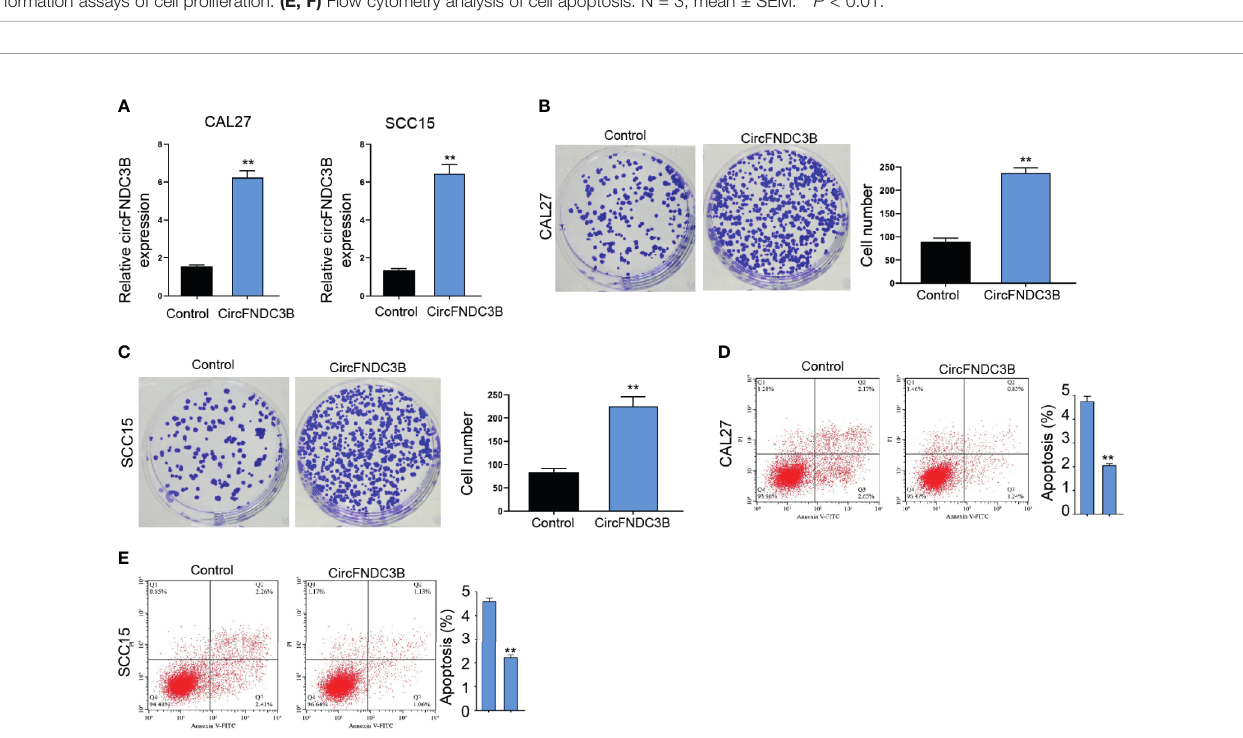
FIGURE 3 | CircFNDC3B promotes OSCC cell proliferation in vitro . (A – E) The pcDNA3.1-circFNDC3B overexpressing vectors treated the CAL27 and SCC15 cells. (A) CCK-8 assays of cell viability. (B, C) Colony formation assays of cell proliferation. (D, E) Flow cytometry analysis of cell apoptosis. N= 3, mean ± SEM: ** P <